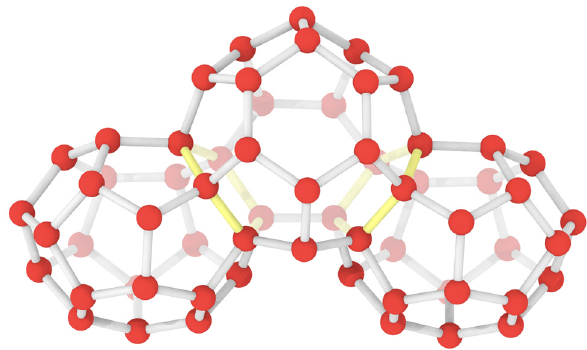
Figure 3: Mechanisms of HTR algorithm to prevent duplicate iden - ti fi cation. The yellow ring is at the intersection of two adjacent cages. When the middle cage is recognized by the yellow ring on the left, it can no longer be recognized by the yellow ring on the right.